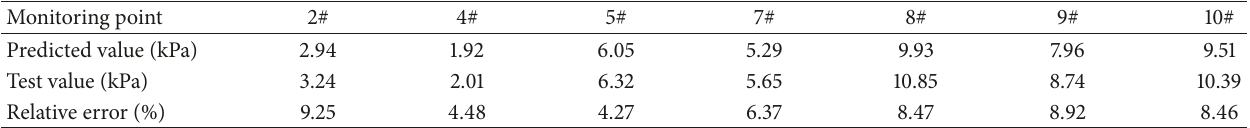
Table 4: Comparison of the predicted values and the test